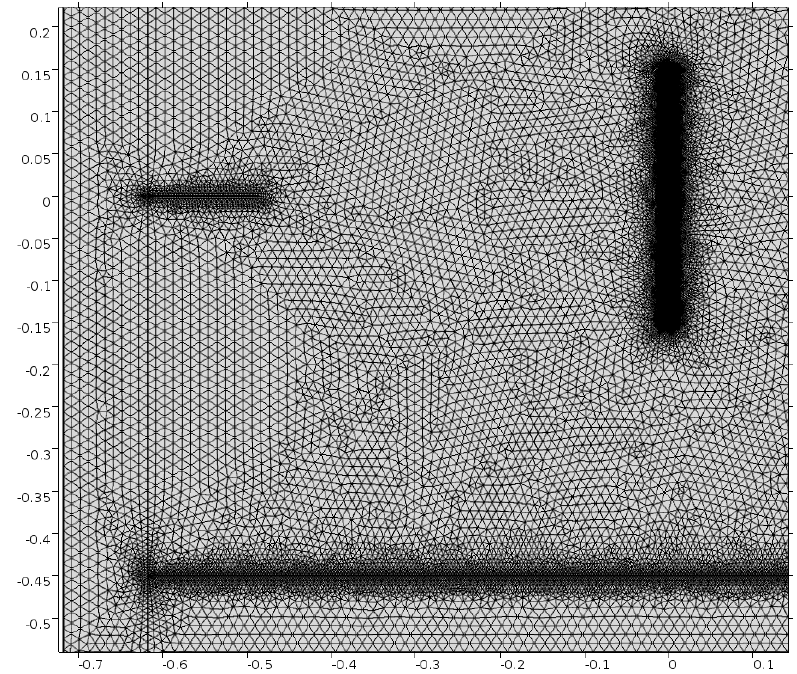
Figure 7. FEM mesh refinements near the regions of the Tx antenna (top left), MUT (top right) and interface air/floor (bottom). The coordinates x (horizontal) and y (vertical) are in